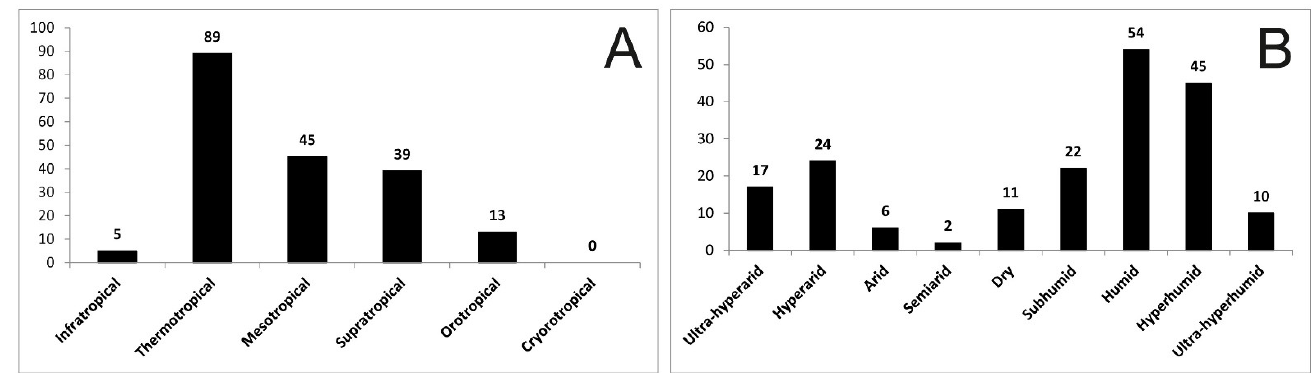
Figure 2. ( A ) Number of localities of the expedition per bioclimatic belt; ( B ) number of localities of the expedition per